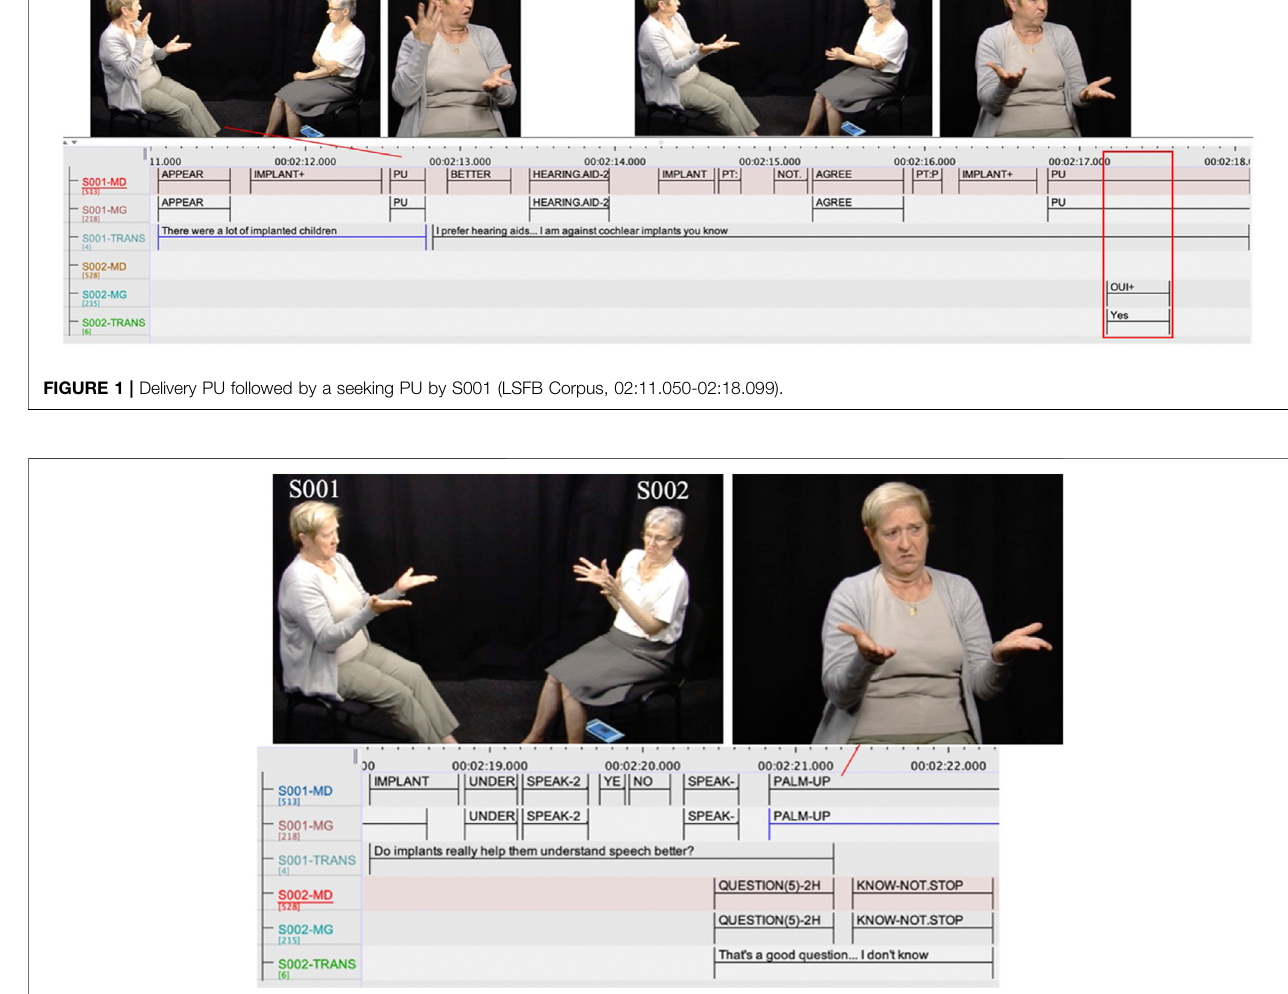
FIGURE 2 | Turn-Yielding PU by S001 (LSFB Corpus, 02:18.212-02:22.287).